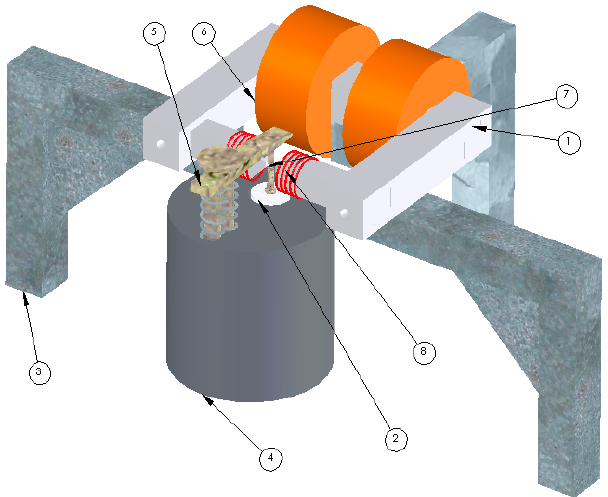
Figure 4. 1. Electromagnet’s poles; 2. Lower contact and ac load system; 3. Electromagnet support; 4. BerlinCourt d 33 measurement system; 5. Top sample contact; 6. DC coils of the electromagnet; 7. Sample; 8. AC coils generating the AC magnetic field. Image developed by the authors and a CAD engineer at NPL as part of the Multiprobe MET 2.1 Project.